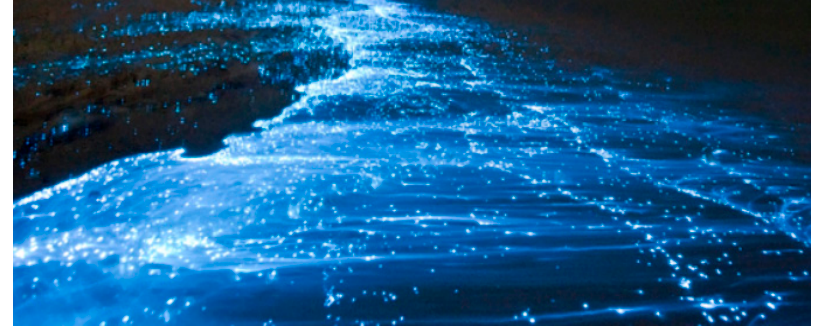
Figure 1. Like bioluminescent phytoplankton organisms that emit light under stress (see beach waves), pretransitional fluctuations produce birefringence by reorientation under shear strain stress (image from https://furthermore.equinox.com/articles/2014/10/seven-incredible-bodies-of-water).